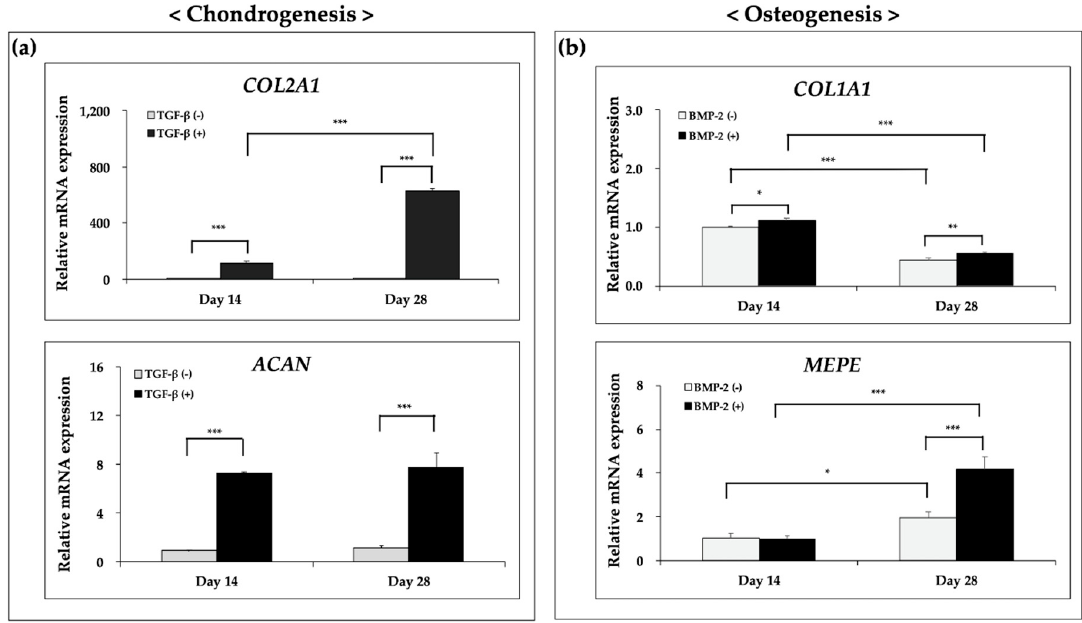
Figure 8. Expression of cartilage- and bone-specific genes. ( a ) Relative expression levels of COL2A1 and ACAN; two-way ANOVA with Sidak’s multiple comparison test. ( b ) Relative expression levels of COL1A1 and MEPE ; two-way ANOVA with Tukey’s multiple comparison test. * p < 0.05, ** p < 0.01, and *** p < 0.001.